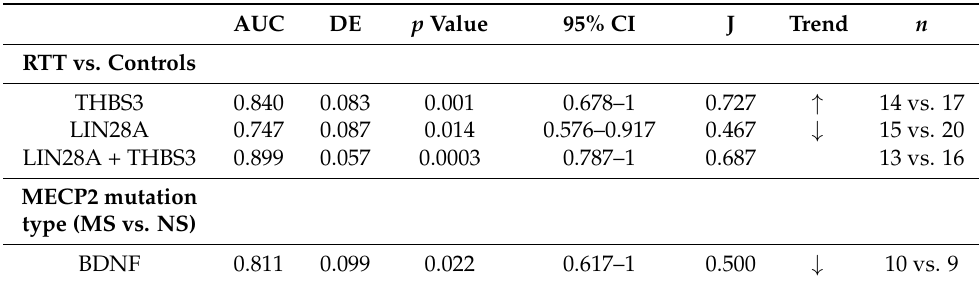
Table 3. BDNF and mRNA performance as RTT